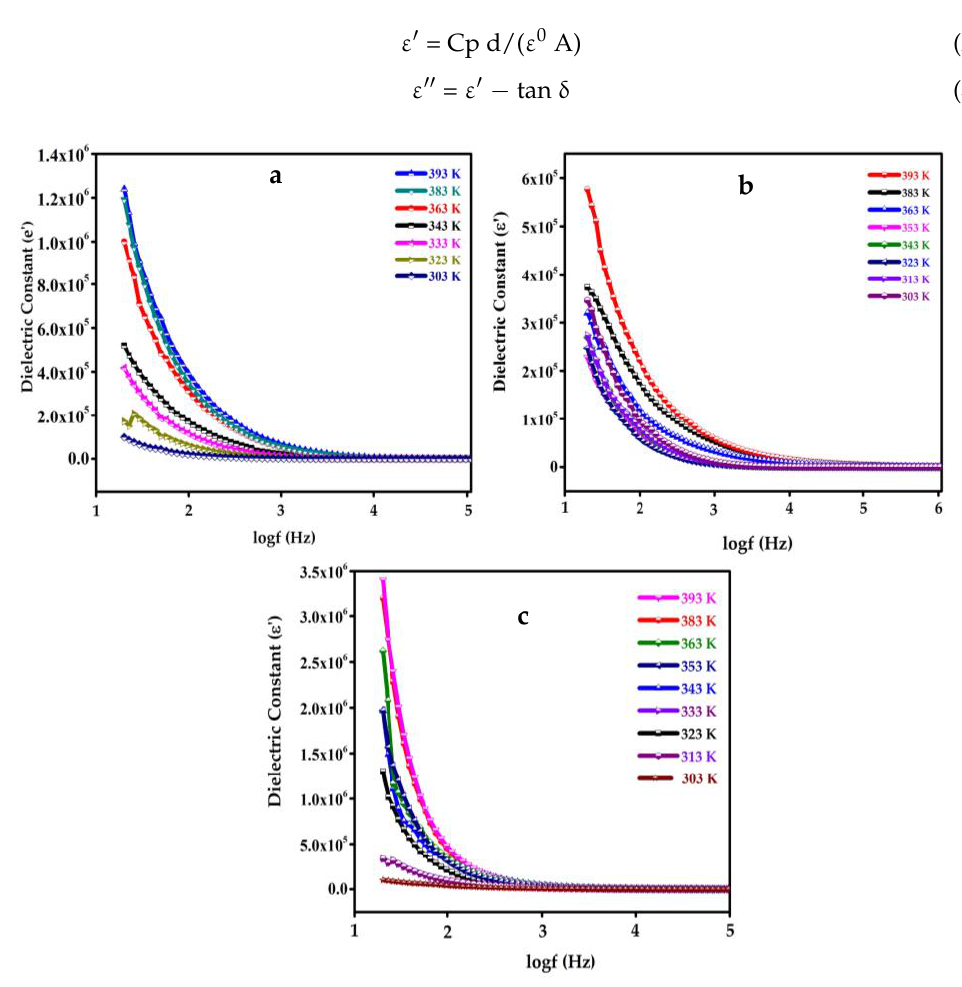
Figure 10. Variation in dielectric constant (ε’) with frequency at different temperatures for ( a ) SnO 2 QDs, ( b ) GO, and ( c ) SGP2 composite film .